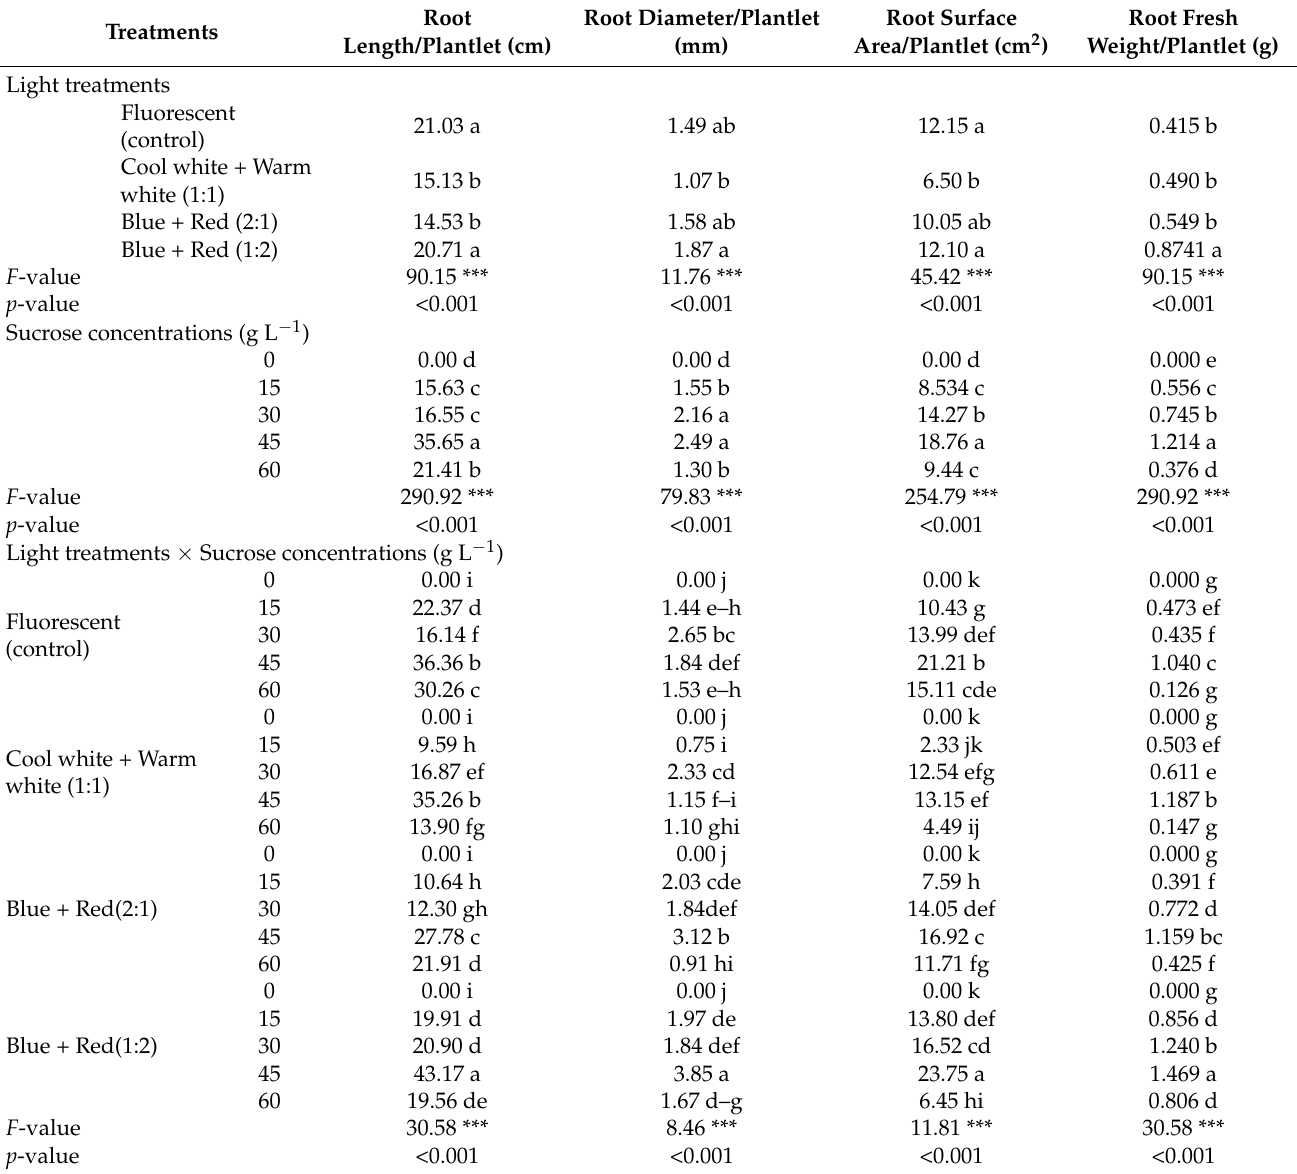
Table 1. Effect of light spectra and sucrose concentration treatments on total root length, root surface area, root diameter, and root fresh weight of in vitro blackberry